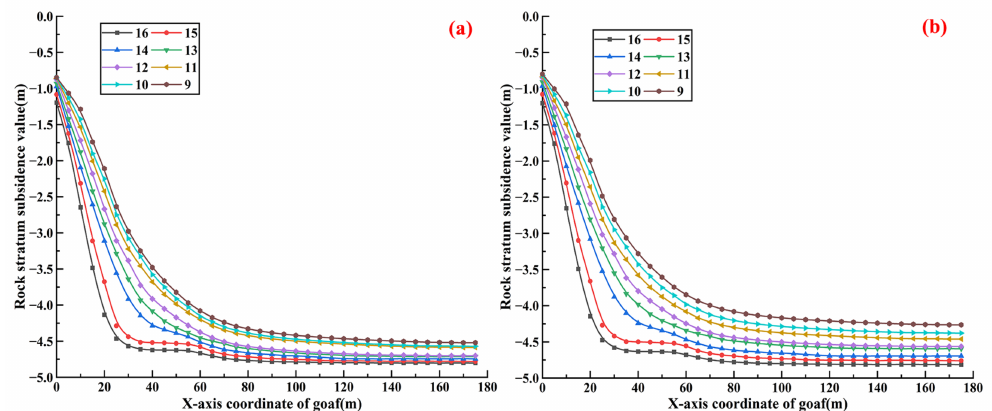
Figure 12. Subsidence values of overlying strata after the corrected strike model of GAWF. ( a ) Goaf of the 11061 working face. ( b ) Goaf of the 11081 working